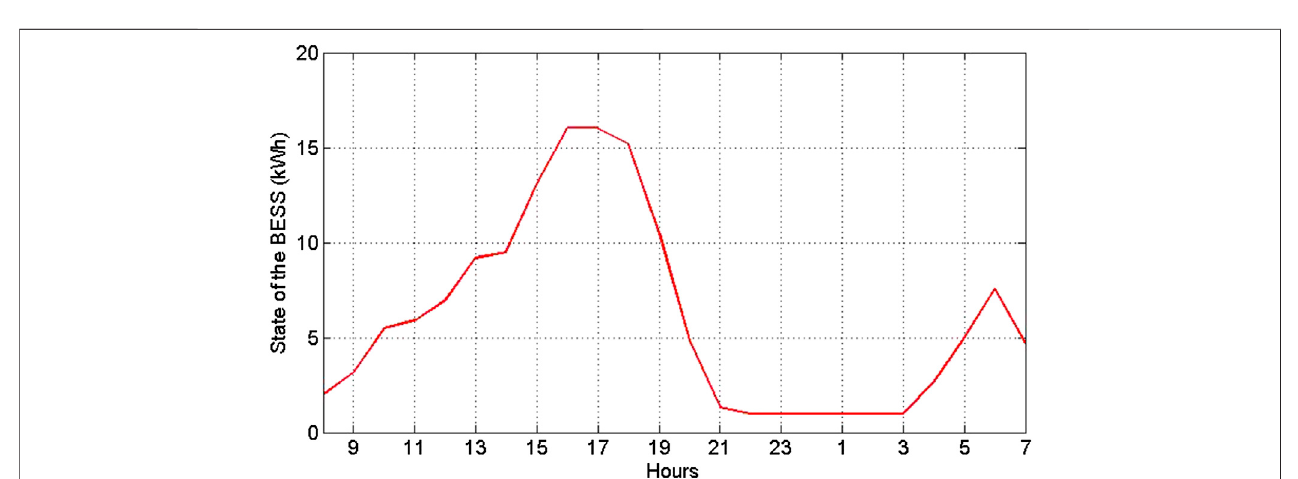
FIGURE 8 | Optimal BESS state.